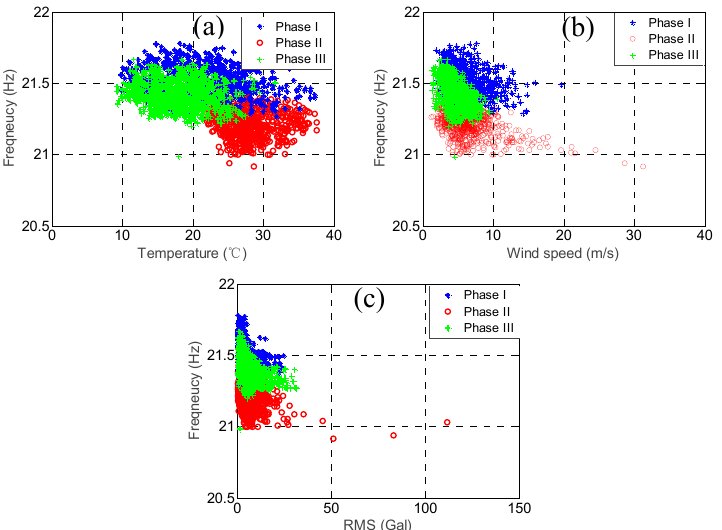
Figure 18. The relationship between the 8th modal frequency (21.39Hz) and ( a ) temperature; ( b ) wind speed; and ( c ) RMS acceleration.